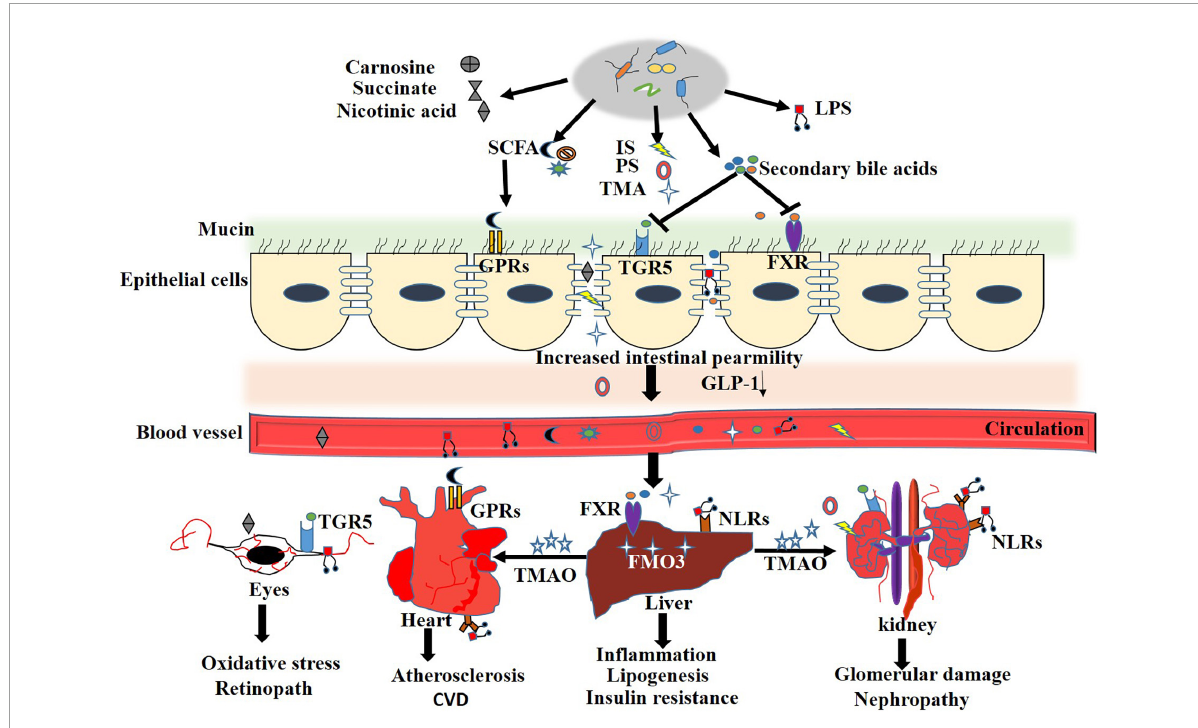
FIGURE2 Mechanisms of gut microbiota in regulation of intestinal barrier integrity. During T2DM and the relate complication, disturbed gut microbiota result in overgrowth of pathogenic bacterium, increased LPS and aberrant metabolites. The microbe-associated molecular patterns (MAMPs) and detrimental metabolites activate TLRs or NODs signaling pathway, change intestinal immune landscape toward a pro-inflammatory phenotype by overproducing of pro-inflammatory cytokines, such as tumor necrosis factor α (TNF α ), Interleukin-1 β (IL-1 β ) and interferon (IFN)- γ , coupled with a loss in barrier protective cytokines interleukin (IL)-17, IL-22 and epithelial mucin. All these contribute to the degradation of epithelial tight junction proteins and increased intestinal permeability. Compromised intestinal barrier leads to abnormal influx of immune-stimulatory microbial products and systemic spread of enteric pathogens and LPS in metabolic